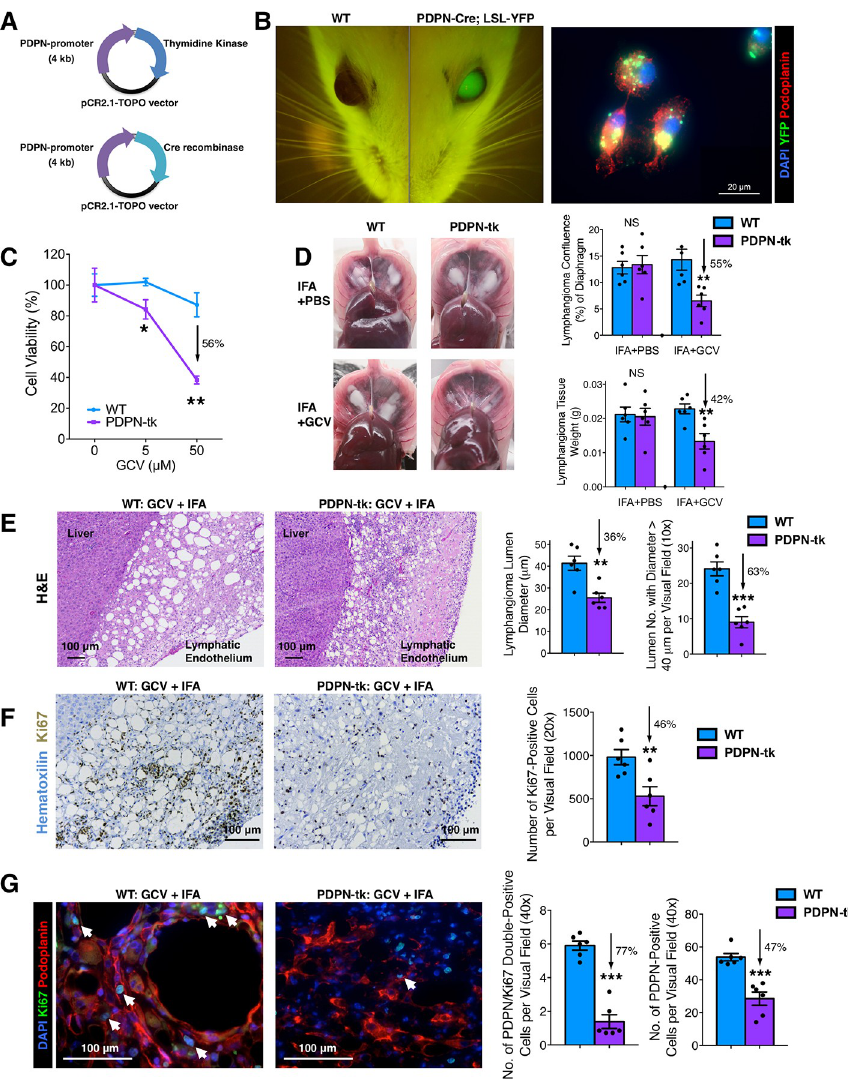
Fig 1. Characterization of PDPN-tk and PDPN-Cre transgenic mice. (A) Schematics demonstrating the generation of PDPN-tk mouse strain or PDPN-Cre mouse strain with a 4-kb PDPN promoter sequence ligated to HSV viral tk sequence or Cre recombinase sequence, respectively, using the pCR2.1-TOPO vector. (B) YFP visualization of the eyes of PDPN-Cre; LSL-YFP and control mice. The expression of YFP and PDPN was examined in primary LECs isolated from IFA-induced benign lymphatic endothelial tumor (lymphangioma) in the PDPN-Cre; LSL-YFP mice. Scale bar, 20 μ m. (C) Cell viability assay of GCV-treated primary LECs isolated from IFA-induced lymphangioma in PDPN-tk or WT control mice. (D) The comparison of IFA-induced lymphangioma formation in GCV-treated PDPN-tk mice, as compared with WT mice or PDPN-tk mice without GCV treatment ( n = 6 mice per group). GCV treatment was conducted as daily intraperitoneal injections of 50 mg/kg body weight of GCV. (E) Histology of the lymphangioma tissue samples from PDPN-tk and WT mice. (F) Ki67 staining on the lymphangioma tissue samples from PDPN-tk and WT mice. (G) Immunofluorescence staining of PDPN (red) and Ki67 (green) on the lymphangioma tissues from PDPN-tk and WT mice. White arrows indicate the nuclei of PDPN and Ki67 double positive cells. Scale bars (E–G), 100 μ m. Data are represented as mean ± SEM. Significance is determined using an unpaired two-tailed Student t test ( � p < 0.05, �� p < 0.01, ��� p < 0.001). The underlying data can be found in S1 Data. Cre, Cre recombinase transgene; GCV, ganciclovir; H&E, hematoxylin and eosin; HSV, herpes simplex virus; IFA, incomplete Freund’s adjuvant; Ki67, cell proliferation antigen Ki-67; LEC, lymphatic endothelial cell; LSL, LoxP-Stop-LoxP; NS, not significant; pCR2.1-TOPO, topoisomerase I-activated pCR2.1-TOPO vector; PDPN, podoplanin; tk, thymidine kinase; WT, wild type; YFP, yellow fluorescent protein.